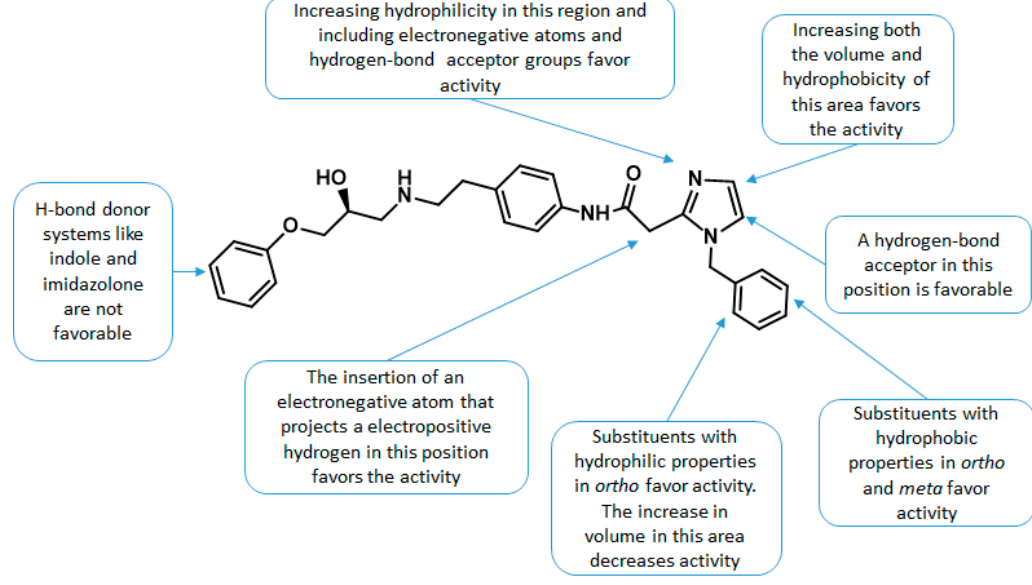
Figure 7. Main structure-activity relationships found in this study.